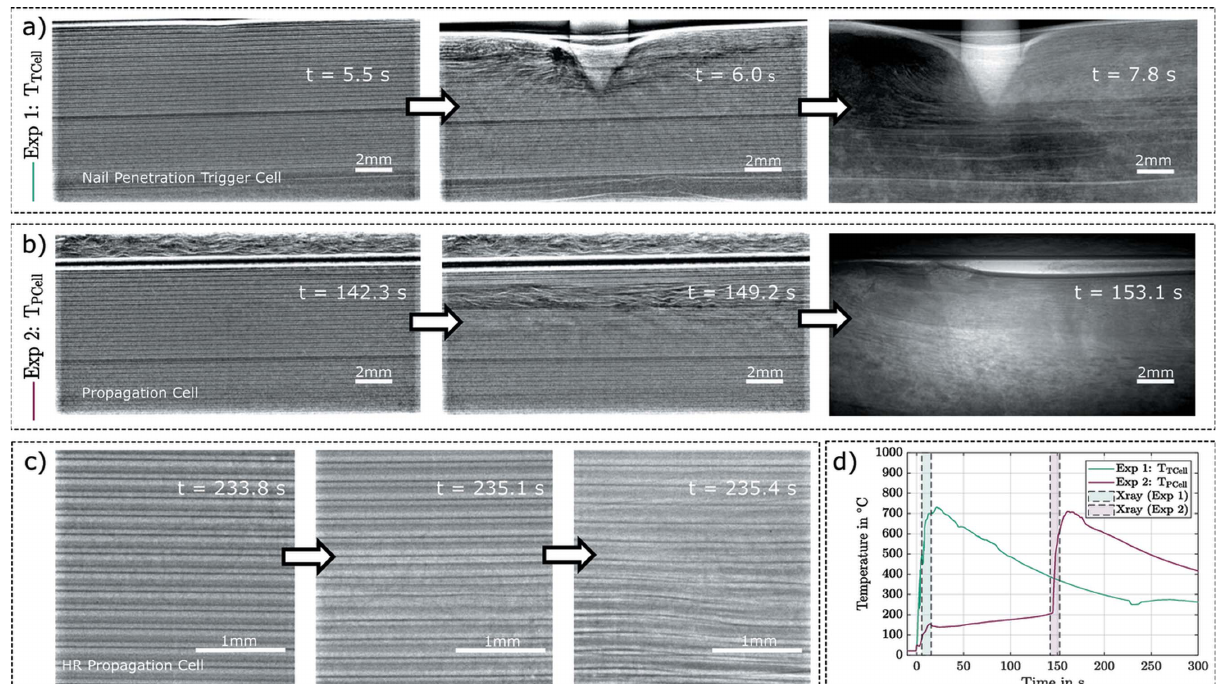
Figure 5 Example images from the high-speed X-ray recording. In Exp.1 ( a ) the cell was punctured directly with the nail, Exp.2 ( b ) and Exp.3 ( c ) show the cells directly under a punctured cell, which also entered a TR due to the temperature rise of the first TR. The setup of the images in ( c ) differs from that of ( a ) and ( b ) by a larger magnification factor (5 (cid:3) ), resulting in a pixel size of approximately 4 m m. The images demonstrate the effects of a TR on the internal cell structure. To time the high-speed X-ray images in the abuse process, the images from Exp.1 and Exp.2 are plotted with the temperature data in ( d ). This facilitates the extraction of complex interrelationships across the entire